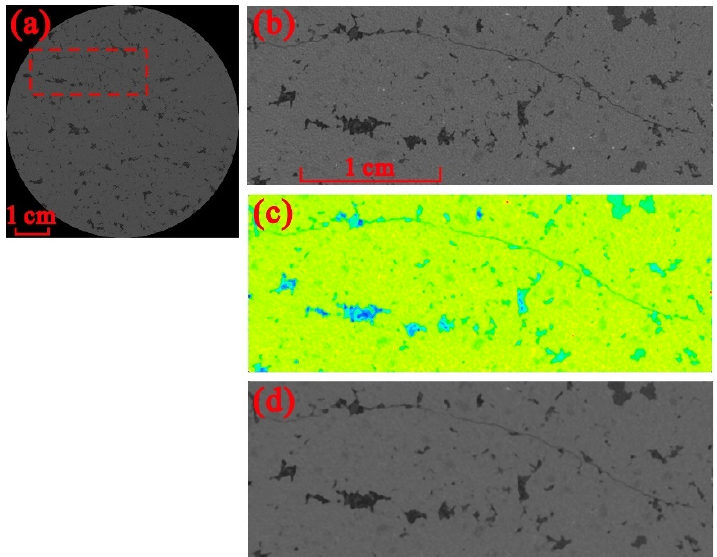
Figure 1. The application of image filtering method to the micro-CT scanned image: ( a ) the micro-CT scanning image, ( b ) the enlarged image, ( c ) the false-colored image, and ( d ) the filtered image. After the false coloring, the pore space is in sky blue and the matrix is in yellow. The speckled random noises are the red dots and Gaussian noises make the matrix a mix of green and yellow.